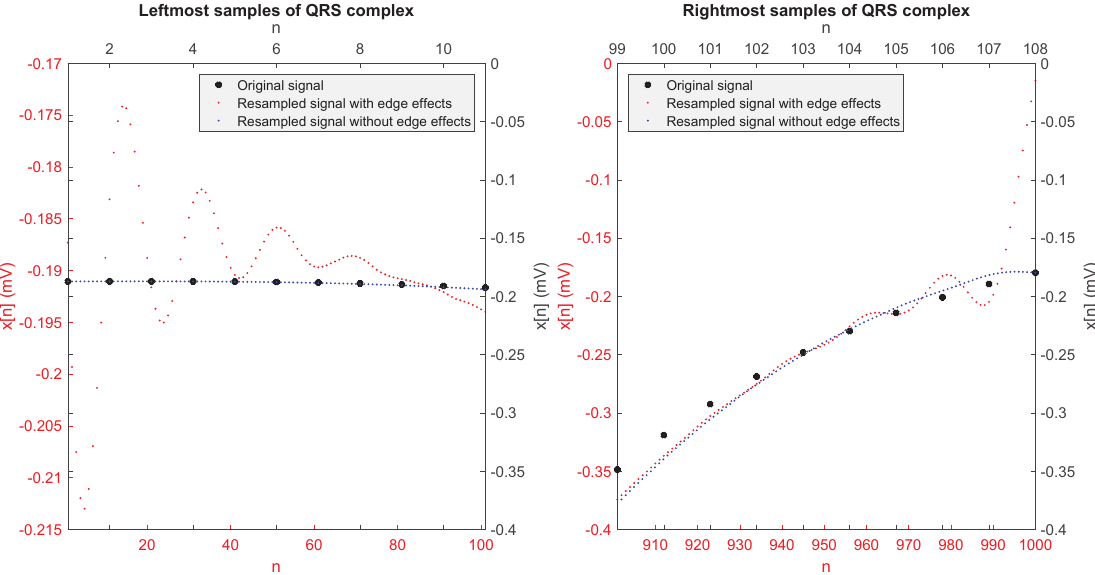
Figure 3. Leftmost and rightmost samples of an original QRS complex (from patient 214 in the PTB database) and its resampled version with and without edge